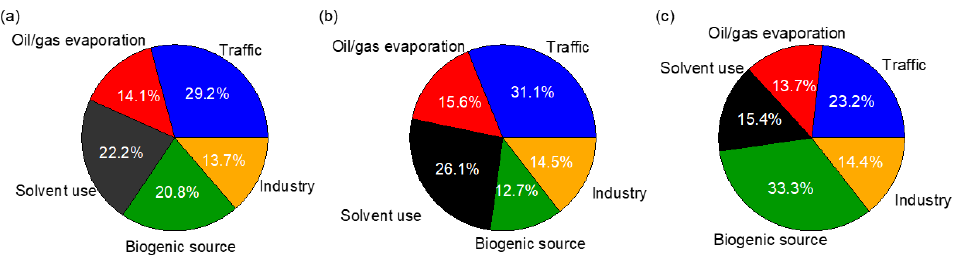
Figure 8. Average mass contributions of different sources to TVOC for ( a ) all samples, ( b ) morning, and ( c ) afternoon samples.